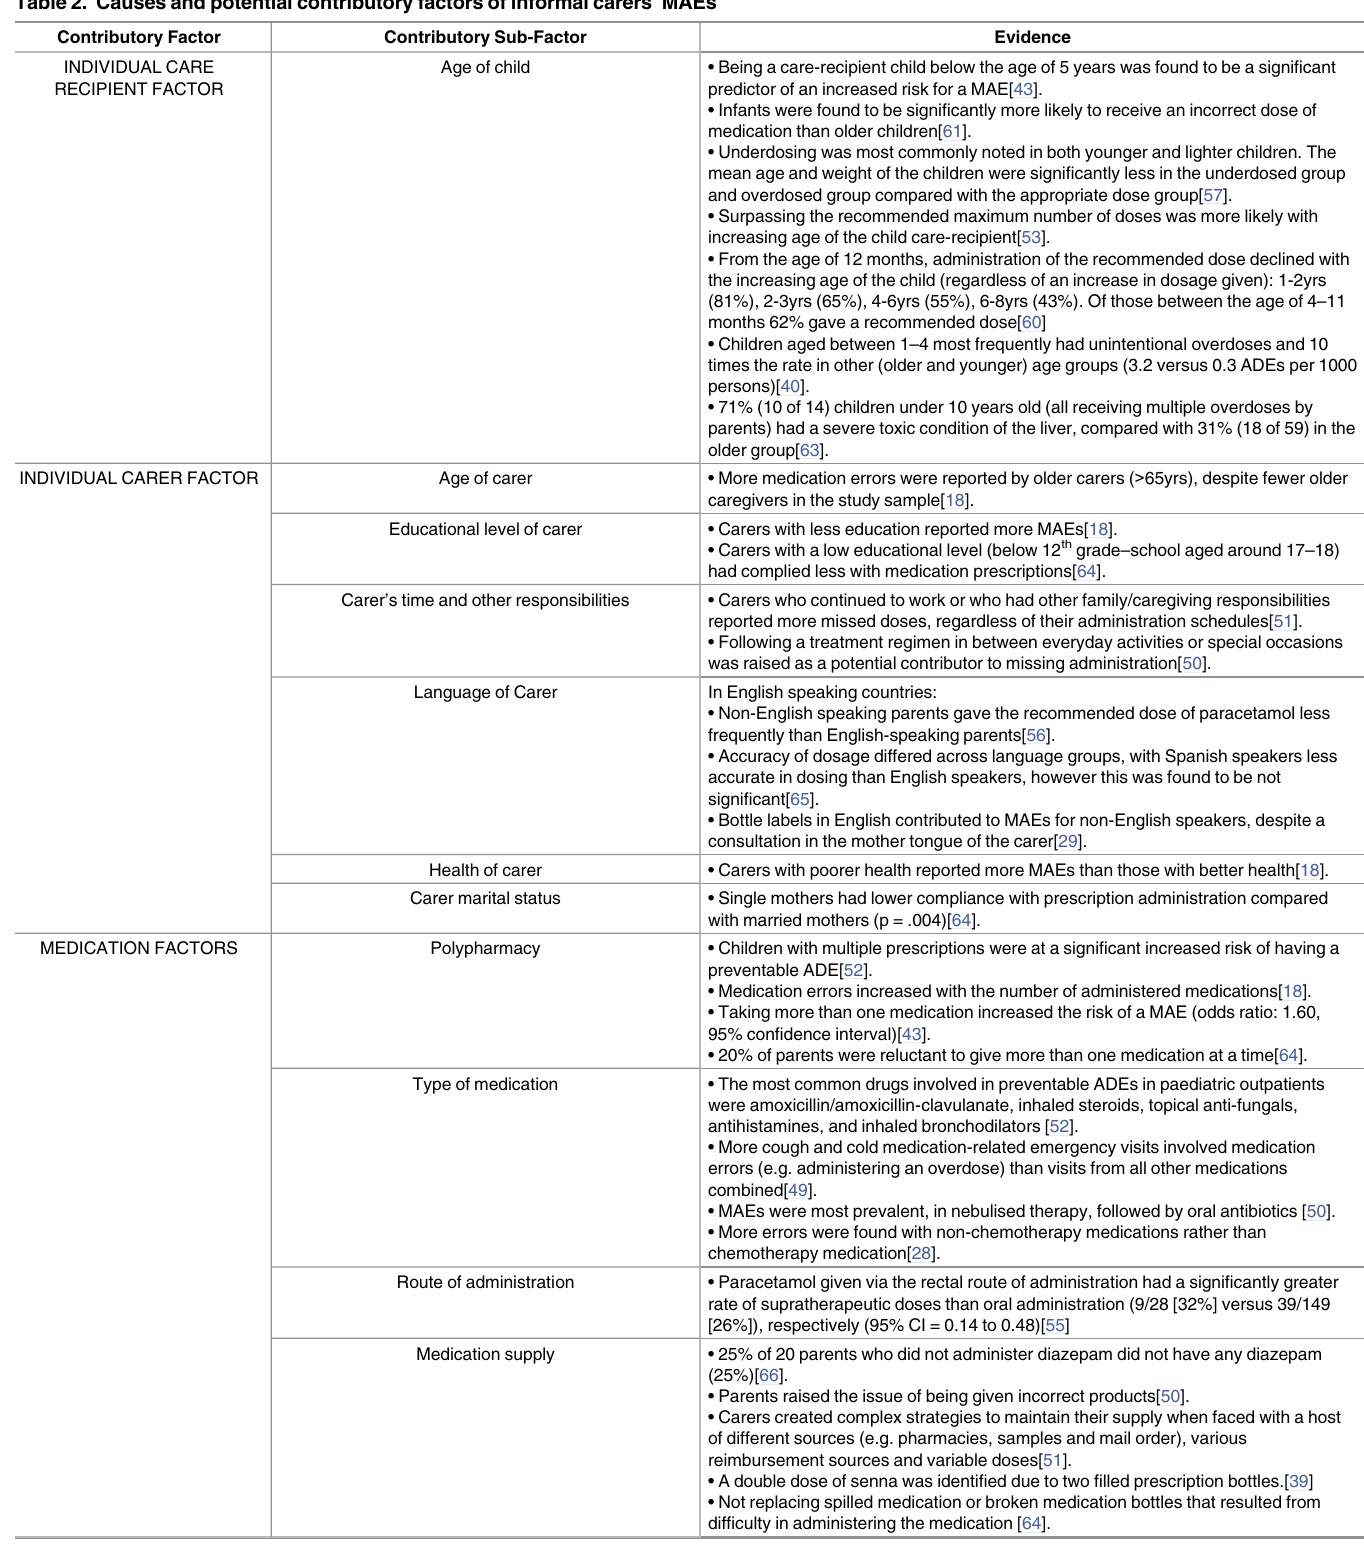
Table 2. Causes and potential contributory factors of informal